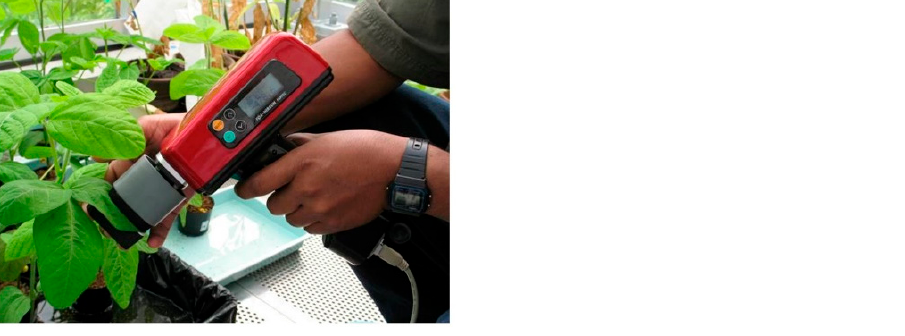
Figure 6. Acquiring soybean leaf spectra by handheld NIR spectrometer with a custom designed probe.